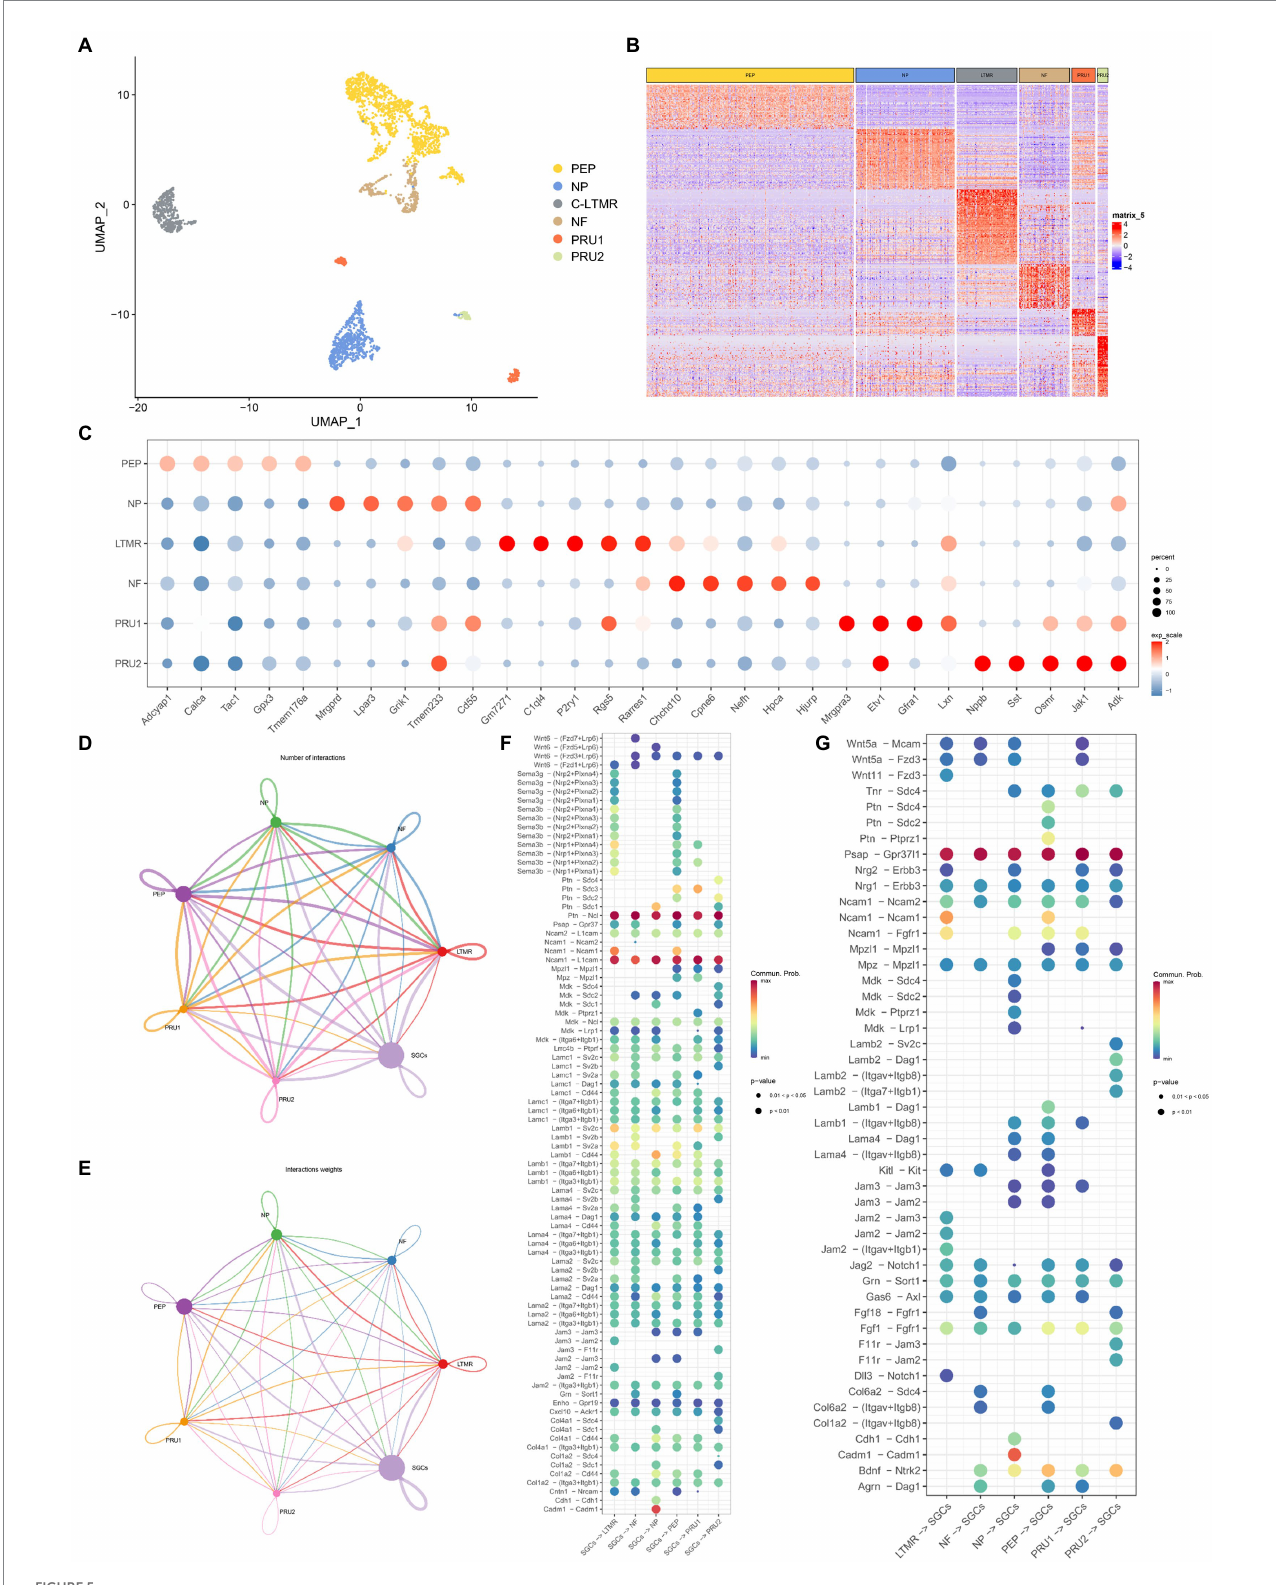
FIGURE 5 Cell-cell communication analysis between neurons and SGCs in TG. (A) The UMAP plot of six neuron subtypes in TG. Number of cells for the neuron subtypes: PEP (1365), NP (649), cLTMR (397), NF (332), PRU1 (155), PRU2 (69). (B) The gene heat map of neuron subtypes in TG. (C) The dot plot of the top 5 maker genes for neuron subtypes in TG. (D) Network of interaction numbers between neurons and SGCs constructed by CellChat. (E) Network of interaction weight between neurons and SGCs. The color of the line is consistent with the cell of ligand origin, and the thickness of the line indicates the interaction strength or the number of interactions. (F,G) The dot plot of interaction scores as the ligand expressing cell-the receptor expressing cell (horizontal axis). Specific ligand-receptor pairs are listed along the vertical axis. The color of the dots indicates the calculated interaction probability, with dark red dots indicating stronger predicted interactions. The ligand-receptor pairs in neurons-SGCs (F) , the ligand-receptor pairs in SGCs-neurons (G)